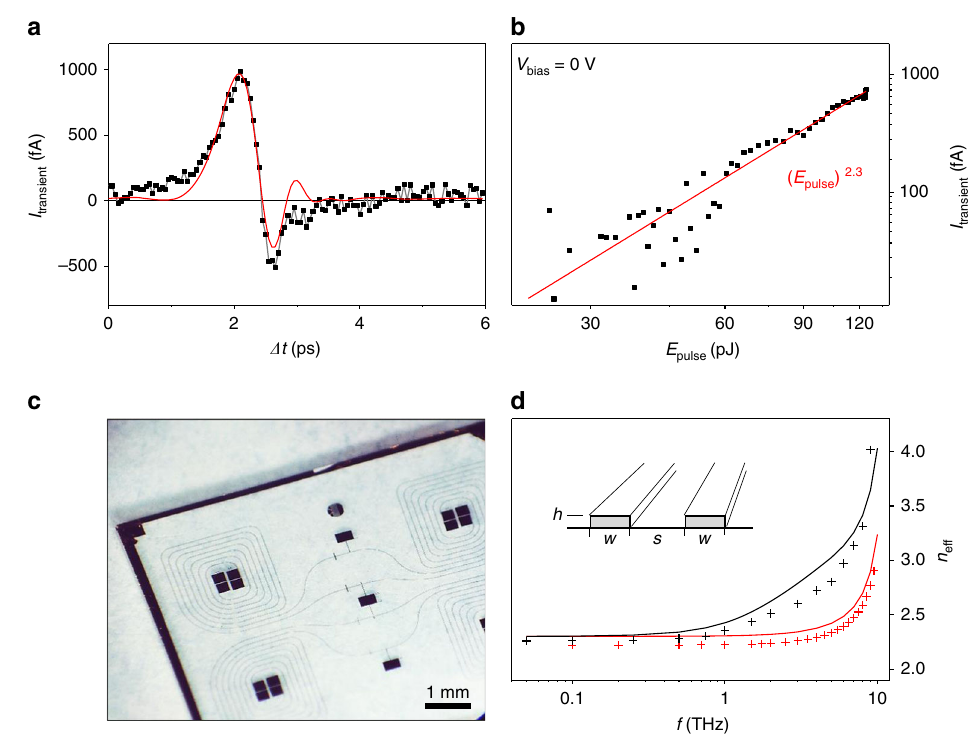
Fig. 3 Non-linear THz pulses in macroscopic on-chip circuits. a Time-resolved I transient vs Δ t (black squares) and fi t function (red line) after exciting a nanojunction integrated in the stripline circuits with a 14 fs laser pulse at E pulse = 124 pJ. The THz signal is detected after a propagation length of 300 µ m. b Non-linear I transient vs E pulse with a power law fi t ( E pulse ) β (red line) showing a similar power law coef fi cient β as found for I emission (cf. Fig. 1d). c Microscope image of the utilized THz-circuitries on a sapphire chip. d Dispersion relation of the effective diffraction index n eff of co-planar gold striplines on a sapphire substrate (inset): black (red) crosses depict numerical simulations with dimensions h = 300 nm, w = 5 µ m (1 µ m), and s = 10 µ m (1 µ m). The black (red) line shows an analytical solution for symmetrically spaced striplines with dimensions: h = 300 nm, w = s = 10 µ m (1 µ m)